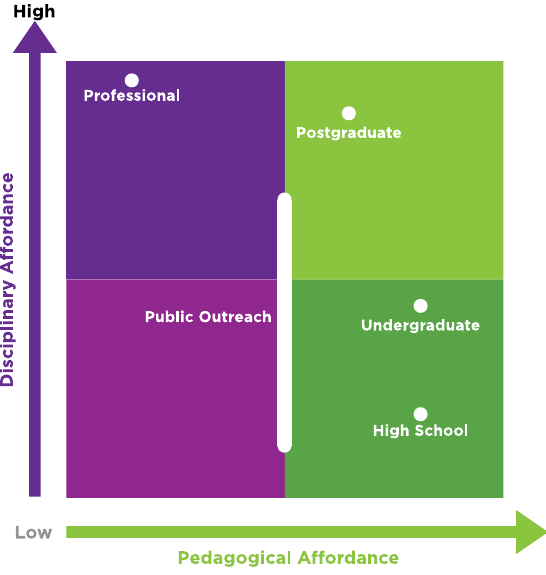
FIG. 37. The distribution of levels based on the disciplinary- pedagogical space. Adapted from the work of Airey and Eriksson [108].